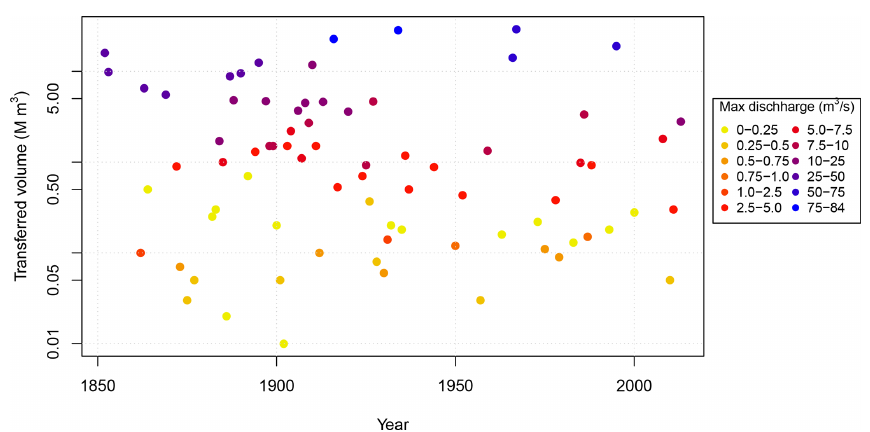
Figure 8. Transferred volume (Mm 3 s − 1 ) and maximum discharge (m 3 s − 1 ) indicated by colour for bifurcation events at Kongsvinger. Estimates are obtained from Aano (2017), Pettersson (2001), Hegge (1968), and Reusch